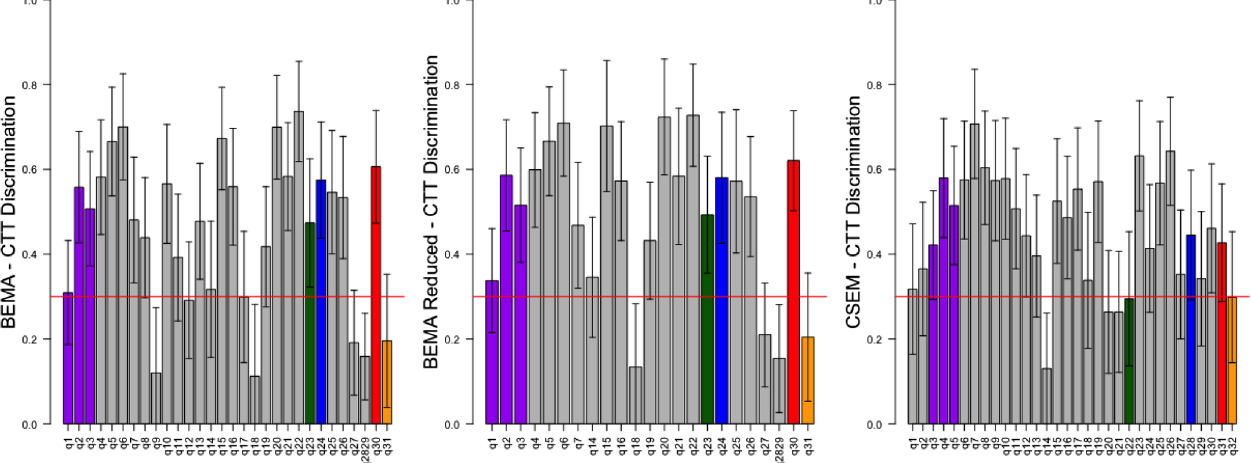
FIG. 4. The error bars are (cid:2) 2 standard deviations from 10 000 randomly sampled classes of 250 students from the full sample for both the BEMA and the CSEM. The horizontal red line indicate the minimum appropriate discrimination for well-functioning questions. The upper and lower 27% was used to calculate the classical discrimination. The colored bars are the 7 identical items between the BEMA and